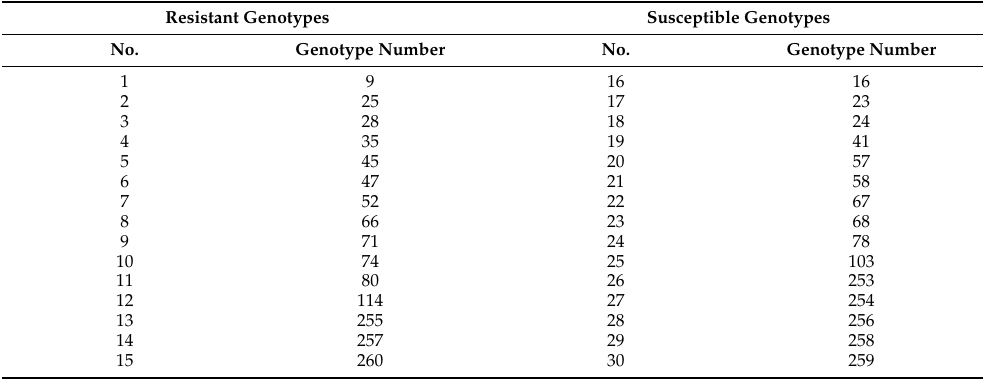
Table 1. Plant material used in the